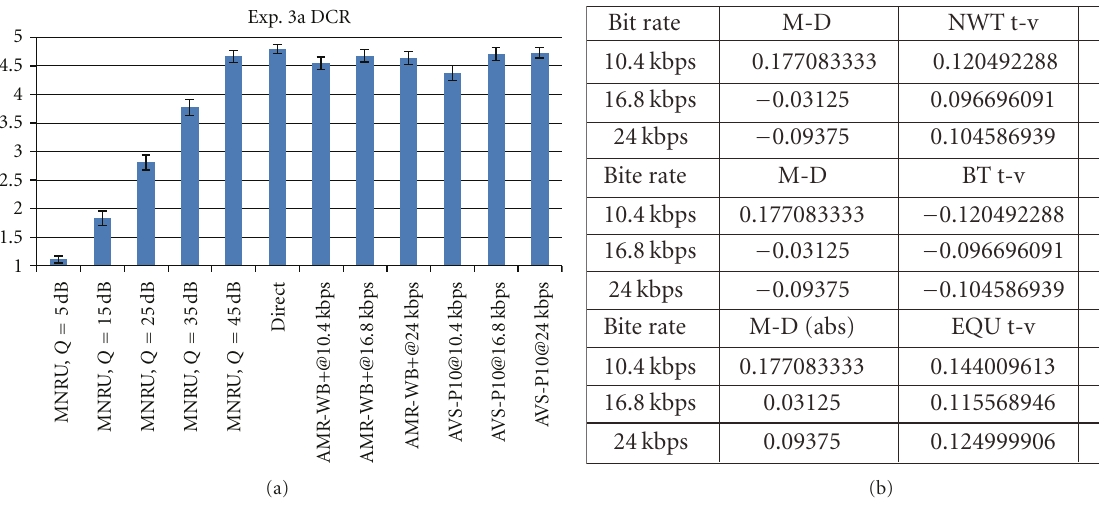
Figure 14: Experiment 3a DMOS scores statistic analysis result and T -test result.